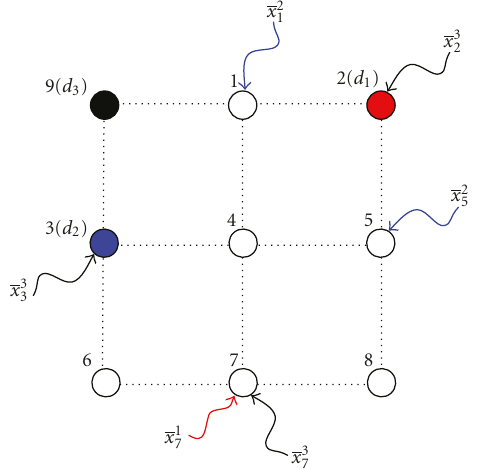
Figure 6: Multihop wireless network with N = 9 nodes and S = 3 commodities. Di ff erent commodities are represented by di ff erent